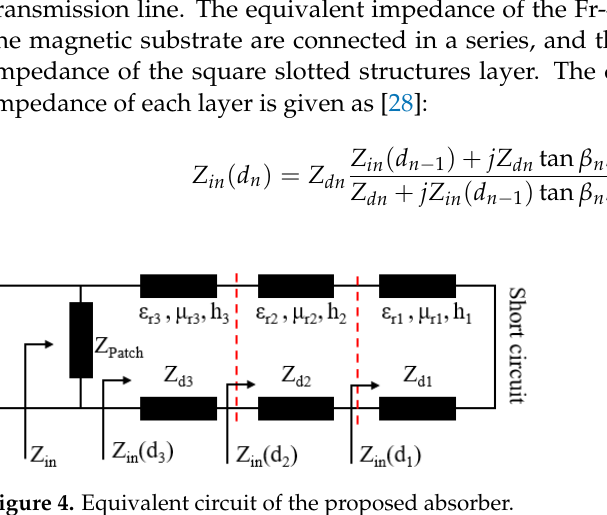
Figure 4. Equivalent circuit of the proposed